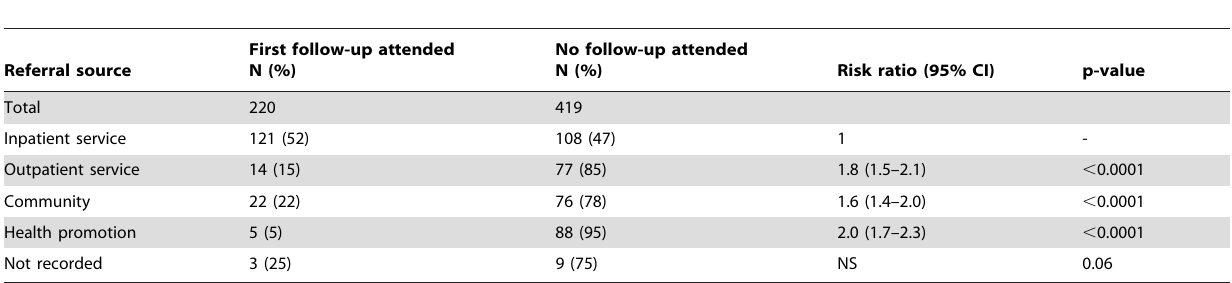
Table 7. Associations between referral source and failure to return for a first follow up consultation among female patients attending mental health services, Timurgara district hospital, Pakistan